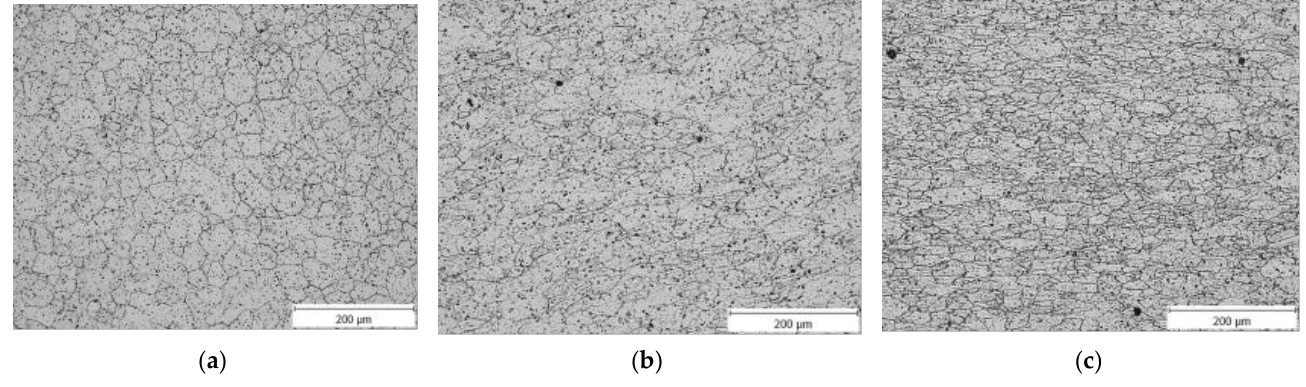
Figure 10. ( a ) Microstructure of the initial material (Sample 0); ( b ) microstructure of the material after one pass through the ECAP die (Sample 1); ( c ) microstructure of the material after four passes through the ECAP die (Sample 4).